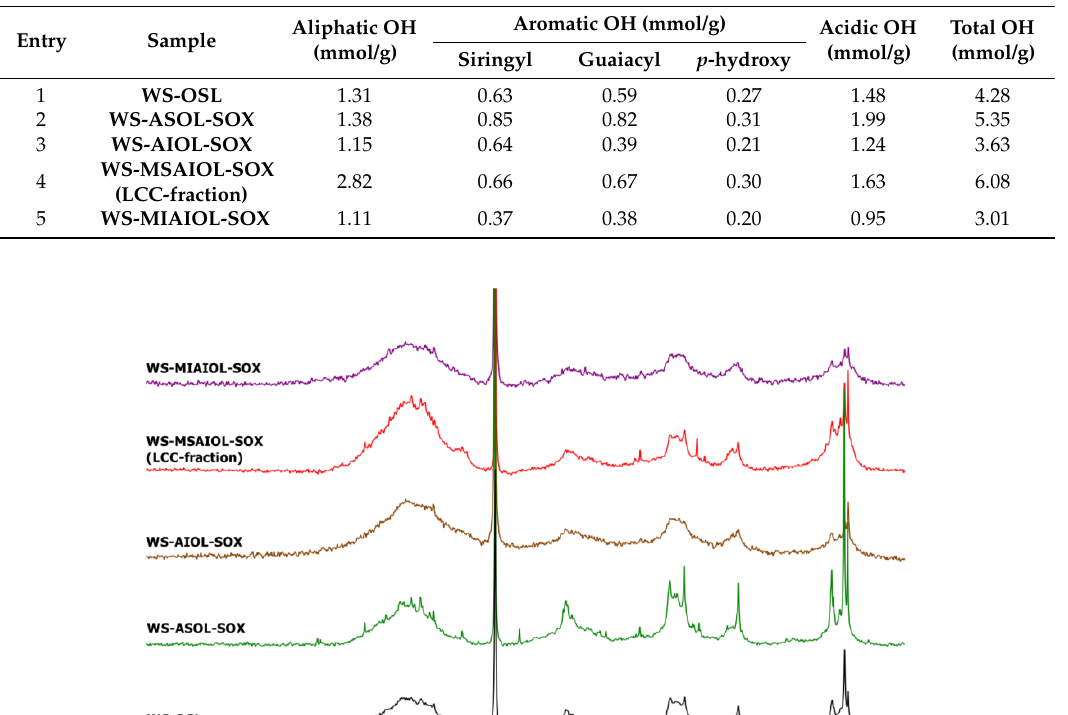
Table 2. OH-group contents obtained for WS OSL and solubility-based fractions thereof after